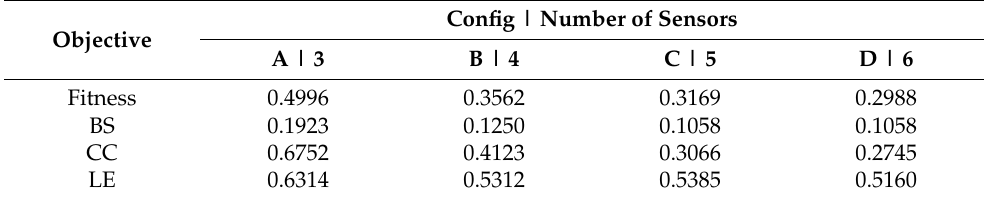
Figure 7. Sensor configuration for NET-A ( a ) Config-A, ( b ) Config-B, ( c ) Config-C, and ( d ) Config-D. Table 4. Performance comparison for NET-A. Table 4. Performance comparison for NET-A.